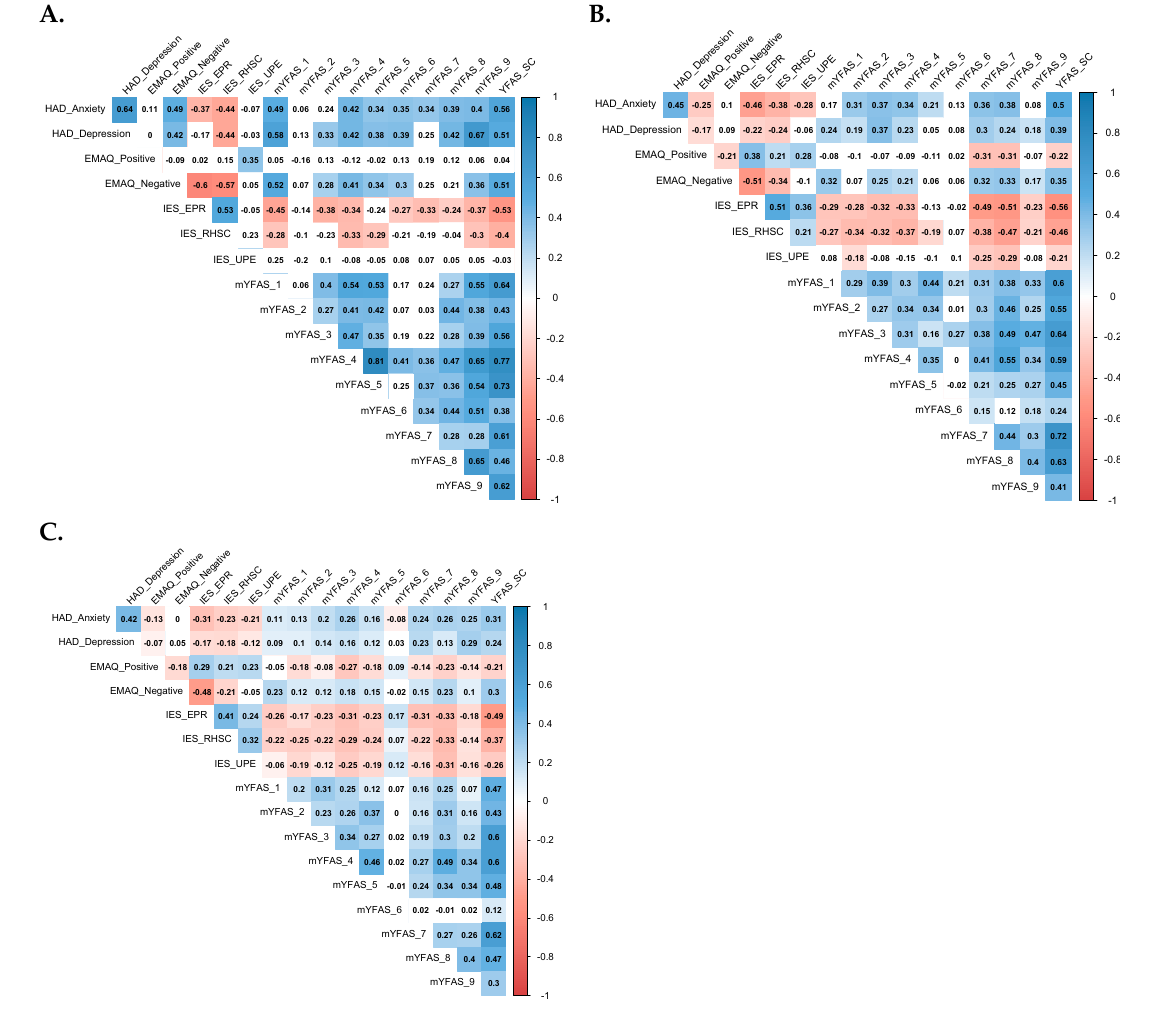
Figure 2. Correlograms for each BMI group. ( A ), Correlogram for Obese group ( n = 57). ( B ), Correlogram for Overweight group ( n = 147). ( C ), Correlogram for Normal Weight group ( n = 938). Positive correlations are displayed in blue and negative correlations are displayed in red. The darkness of the color is proportional to the correlation coefficient, such that the strong correlations (i.e., the closest to − 1 or 1) are represented in dark boxes. Nonsignificant correlations are displayed in white. HAD Anxiety: Hospital Anxiety and Depression Scale—Anxiety subscale. HAD Depression: Hospital Anxiety and Depression Scale—Depression subscale. EMAQ Positive: Emotional Appetite Questionnaire Positive subscale. EMAQ Negative: Emotional Appetite Questionnaire Negative subscale. IES-2: Intuitive Eating Scale 2; -EPR: Eating for physical rather than emotional reasons; -